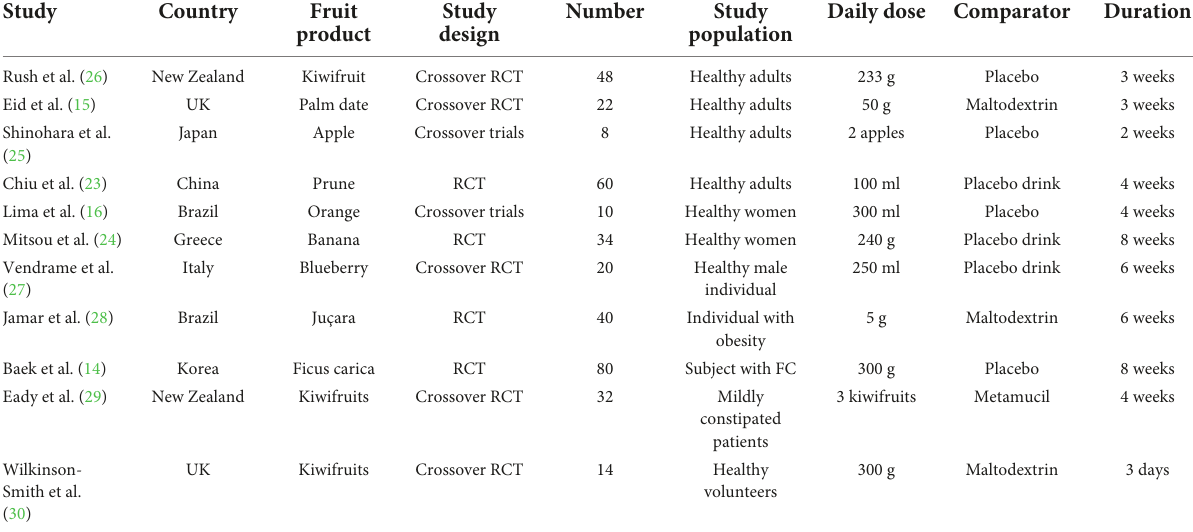
TABLE 1 Summary of the human trials investigating the effect of fruits on functional constipation (FC).